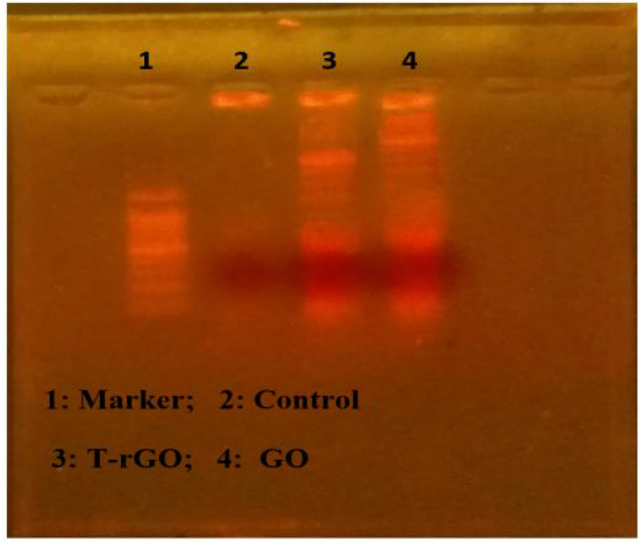
Figure 11. DNA fragmentation. Cells were incubated with GO (62.5 µg/mL) and T-rGO (62.5 µg/mL) for 24 h; after incubation, DNA was extracted from cells and resolved on agarose gel electrophoresis.